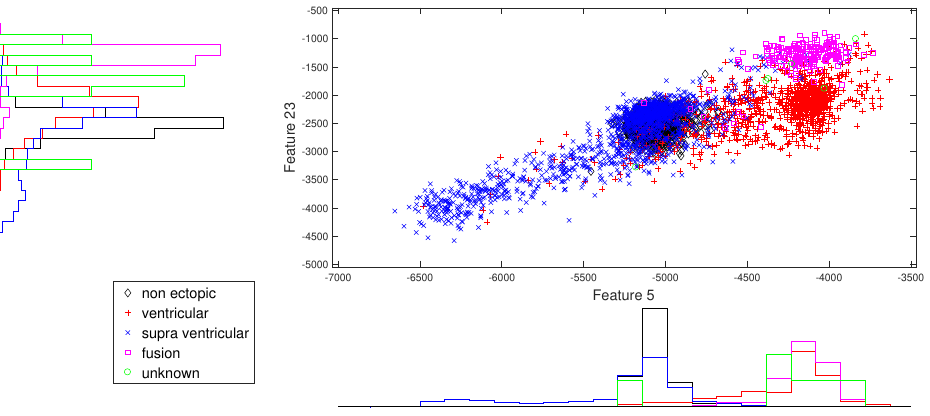
Figure 6. Scatter plot with marginal histogram for log entropy (IMF1) vs. log entropy